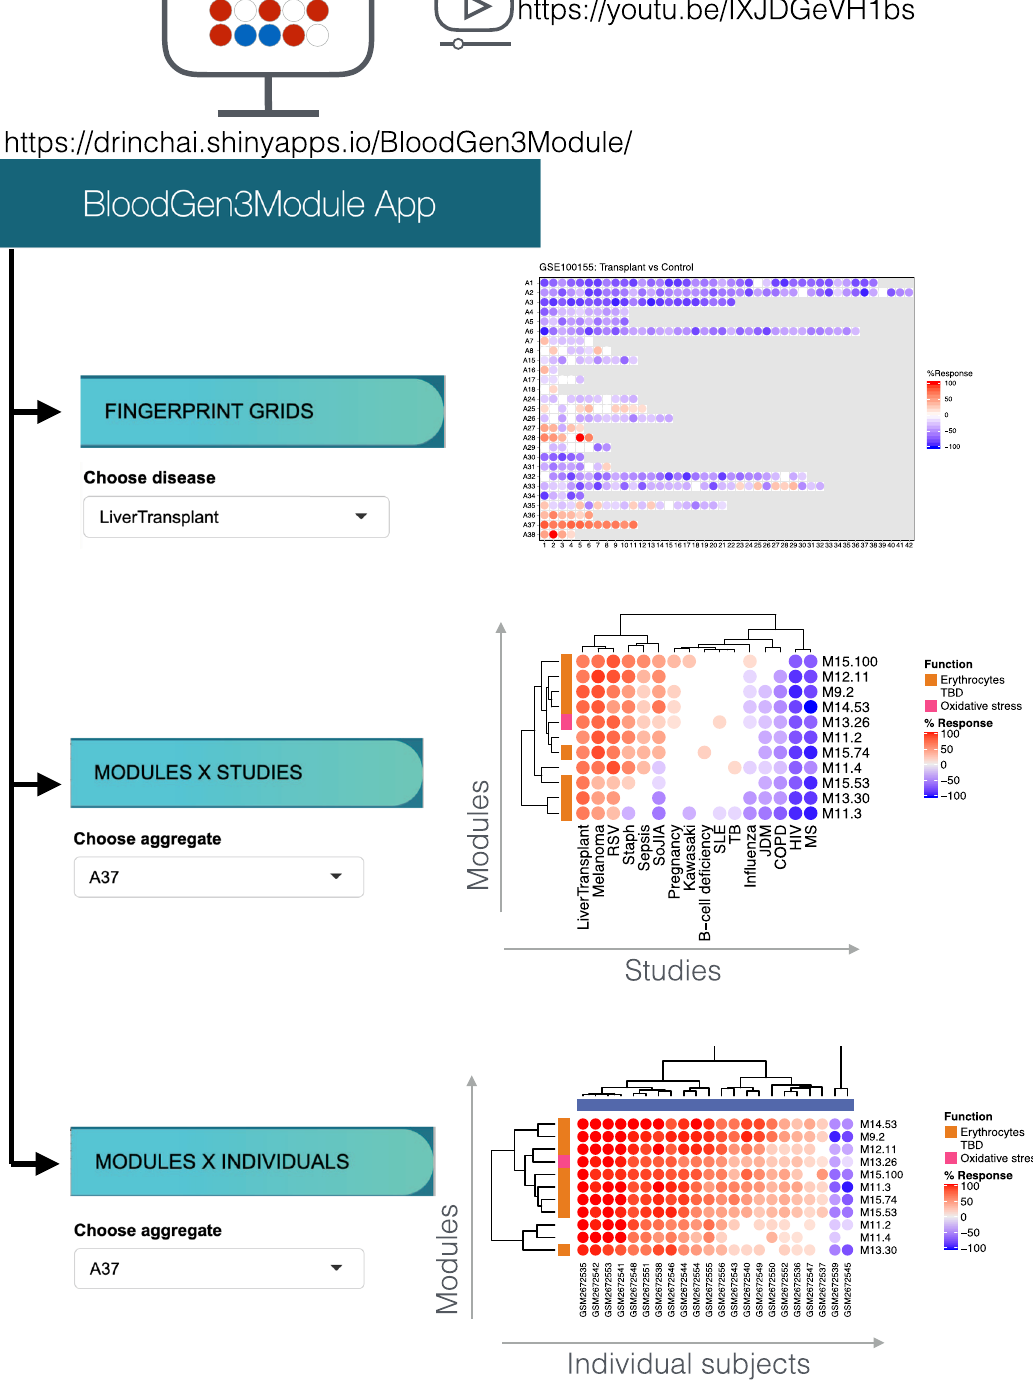
Fig. 6 Web application to visualize multi-tiered module fi ngerprinting. An application was developed to explore the changes in transcript abundance at the module level across the 16 reference datasets used to construct the repertoire. Three types of plot can be displayed and exported: (1) fi ngerprint grids; (2) module heatmaps displaying changes in abundance in modules comprising a given aggregate across the 16 reference datasets; and (3) module heatmaps displaying changes in abundance in modules comprising a given aggregate across individuals constituting a given dataset. To access the application, please visit: https://drinchai.shinyapps.io/BloodGen3Module/. For a demonstration video, please visit: